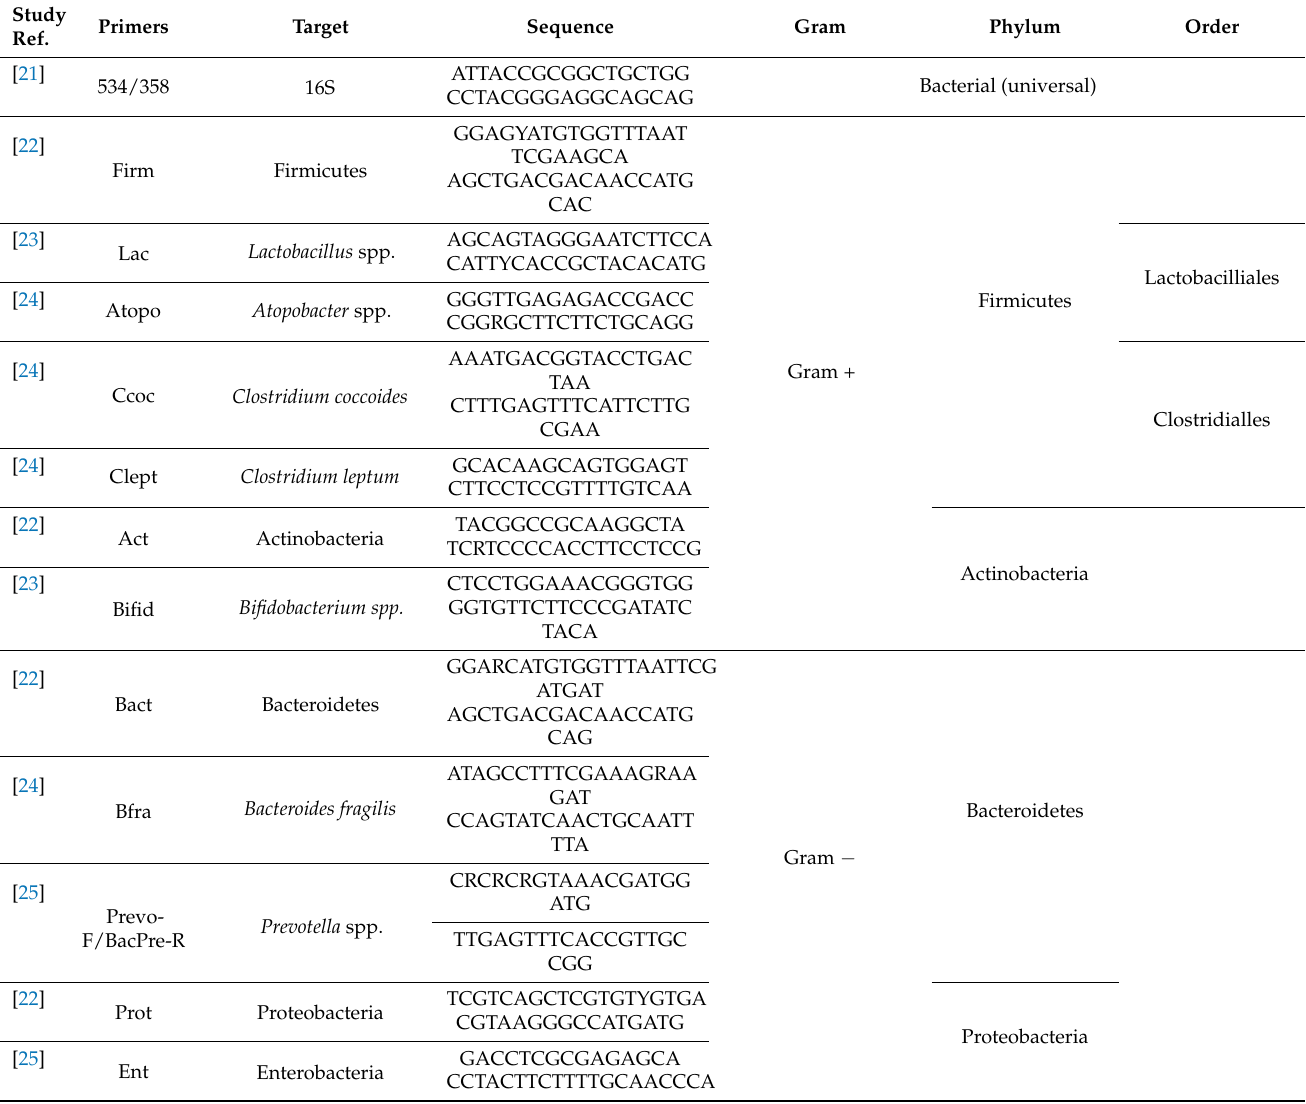
Table 1. List of primers used for microbiota phylogenetic